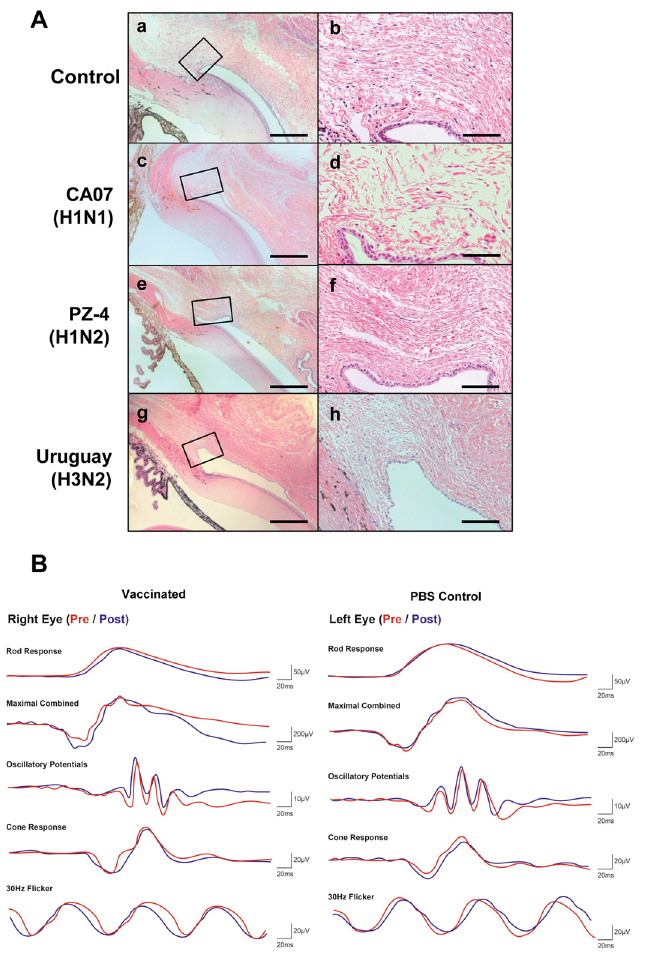
Fig 5. Eyedrop inoculation of vaccine-strain LAIVs does not induce inflammation in ferret eye tissues. (A) Histology of eye tissues 24 h after PBS (a, b) and various LAIVs including CA07 (H1N1) (c, d), PZ-4 (H1N2) (e, f), Uruguay (H3N2) (g, h) on eyes of ferrets. b, d, f, and h are magnified ones of the rectangle area in their paired pictures. (B) After the ferrets were dark-adapted for 12 h, full-field ERG recording was performed on both eyes of under the anesthesia (Pre), then retaining the ferrets in dark room for ferret ’ s dark- adaptation eyedrop CA07 (H1N1) LAIV was administered only on right eye. After 24 h the eyedrop vaccination, full-field ERG recording was performed again on both eyes of under the anesthesia